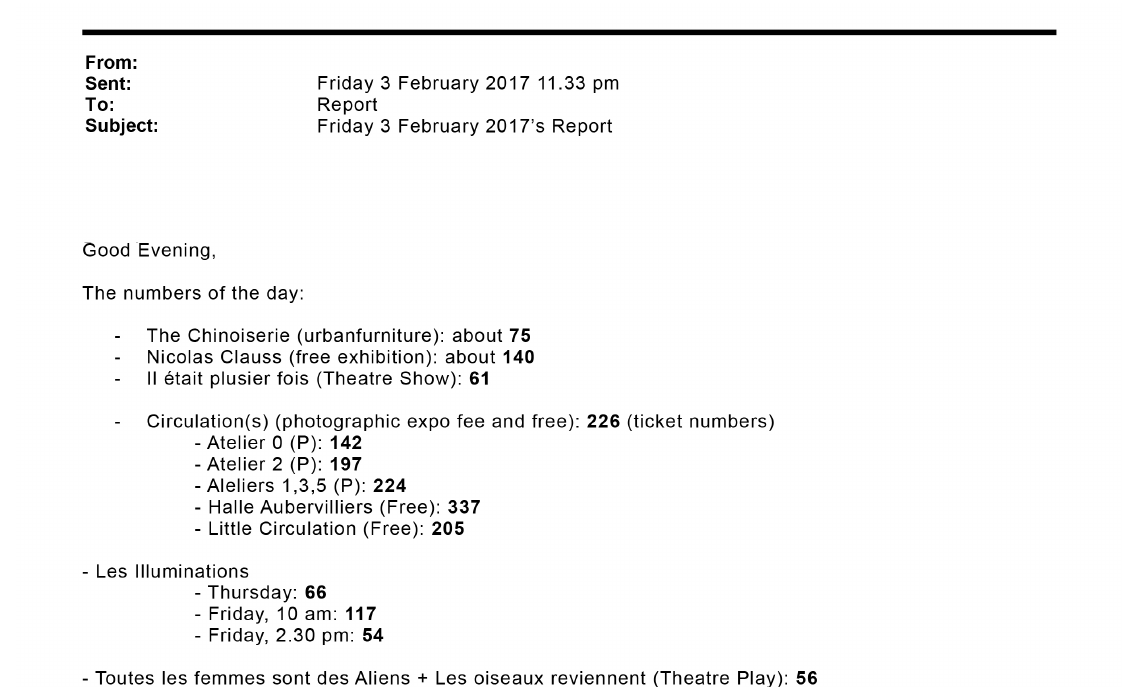
Figure 6. Daily report for 3 February 2017 c (cid:13)